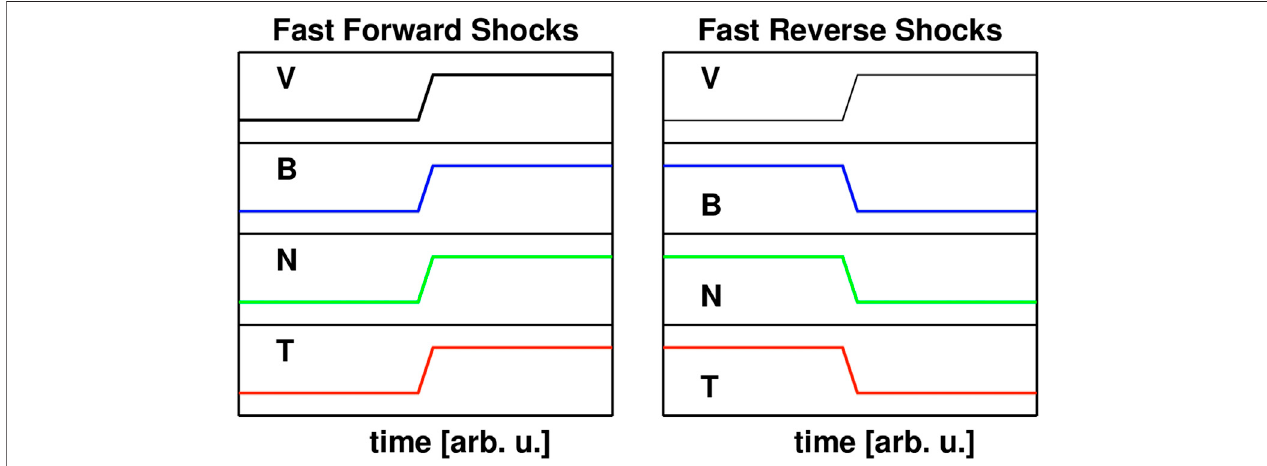
FIGURE 1 | Pro fi les of the solar wind velocity, V , magnetic fi eld magnitude, B , density, N , and temperature, T , across Fast Forward and Fast Reverse